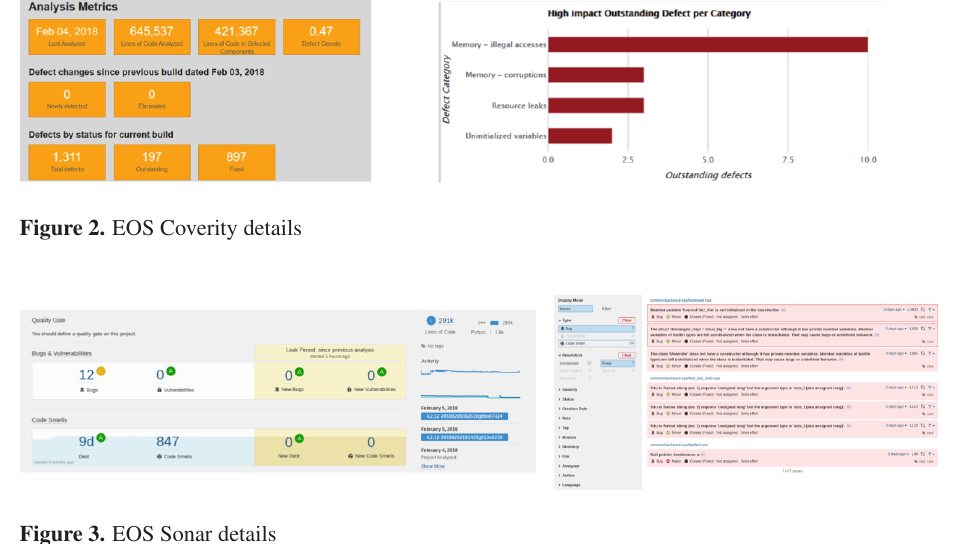
Figure 3. EOS Sonar